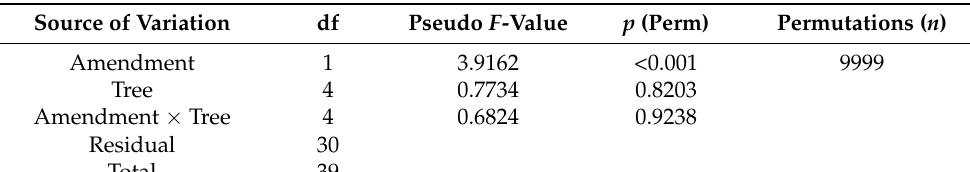
Table 3. PERMANOVA testing of community structure in relation to the effect of amendment application (PMS35+topsoil and topsoil) and tree plantation ( L. laricina, B. papyrifera , P. resinosa , a mix of the three species, and the no-tree control) at the Niobec site.